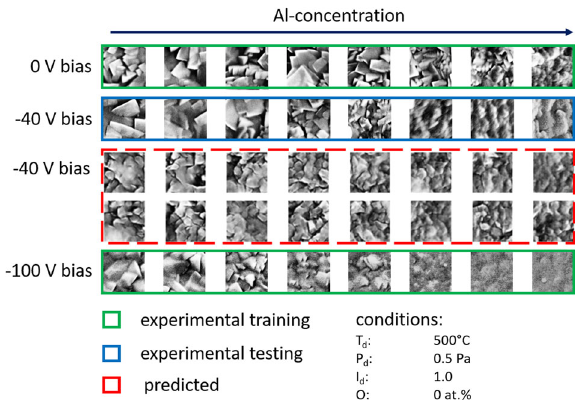
Fig. 5 Synopsis of experimental and predicted images. The data shows the effect of bias voltage ( E I ) and Al concentration on the surface microstructure. The blue box contains images from the experimental test set. The red dashed box shows cGAN predictions for the exact conditions of the experimental test set. The green boxes show images from the experimental training